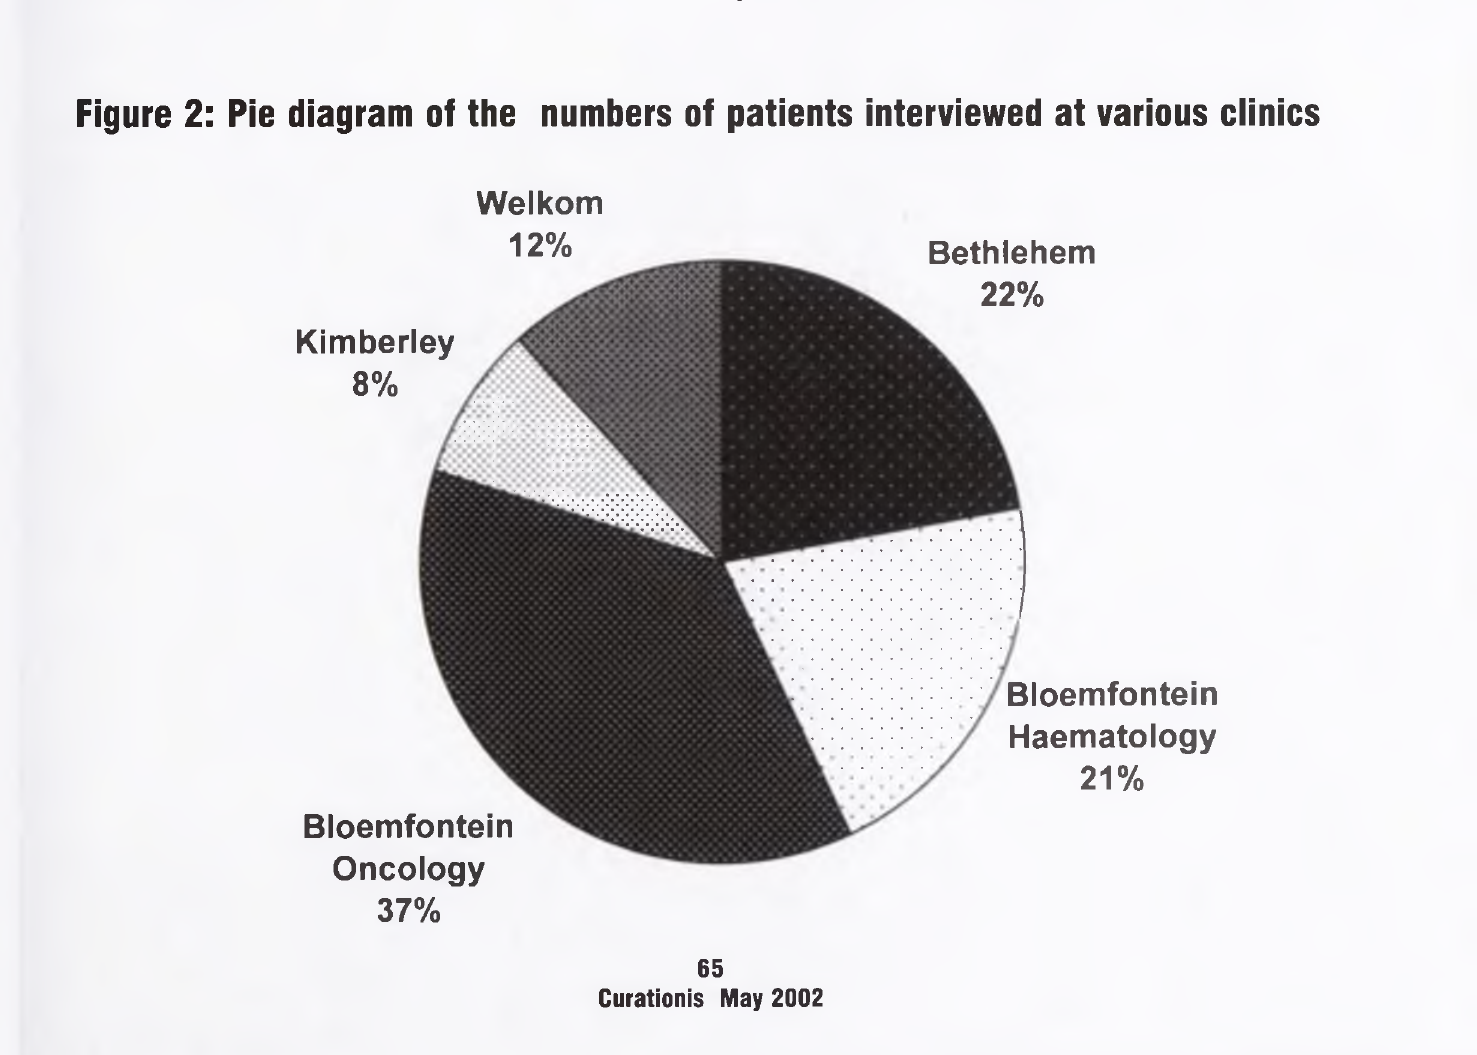
Figure 2: Pie diagram of the numbers of patients interviewed at various